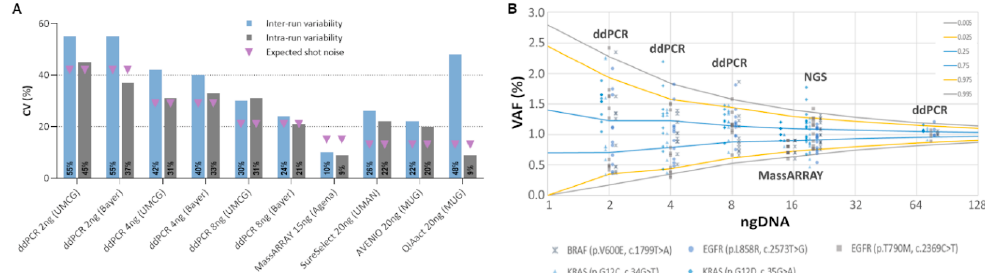
Figure 2. Inter- and intra-run variability of three qPCR-based and three NGS assays calculated from five clinically relevant mutations in three replicates. The use of the SeraCare Seraseq ctDNA Complete reference material (VAF1%) was evaluated using two digital droplet PCR assays (ddPCR) (one ISO15189 certified [ISO (UMCG)] and one research use only [RUO (Bayer)], the MassARRAY (UltraSeek lung panel) and three NGS panels (a custom SureSelect design, the AVENIO Targeted kit, and the QIAact Lung UMI Panel). Five clinically relevant mutations, i.e., BRAF V600E, EGFR T790M, EGFR L858R, KRAS G12C and KRAS G12D were taken into account. ( A ) Plotted are the coefficients of variations (CV) of observed VAFs of all tested assays. Shown are inter- and intra-run variability (three replicates each) as well as the calculated random error (shot noise) based on the availability of mutant input molecules. ( B ) Shown are VAFs for various input masses of DNA calculated from three NGS panels (20 ng), the MassARRAY (15 ng), and two ddPCR assays (8, 4, and 2 ng), demonstrating that the amount of input DNA (i.e., available molecules) clearly affects the variability of a test. Plotted are the respective VAFs as well as an inverse binomial distribution based on the trials (how many copies of DNA were analyzed), the likelihood of an event happening (0.01 for 1% VAF), and the location along the cumulative distribution function (colored line, e.g., 2.5th percentile would be 0.025). For example, when sampling a 4-ng input DNA, one can expect to observe a 1% variant between VAFs of 0.44% and 1.57% with a likelihood of 95%, or between 0.35% and 1.85% with a likelihood of and 99%.